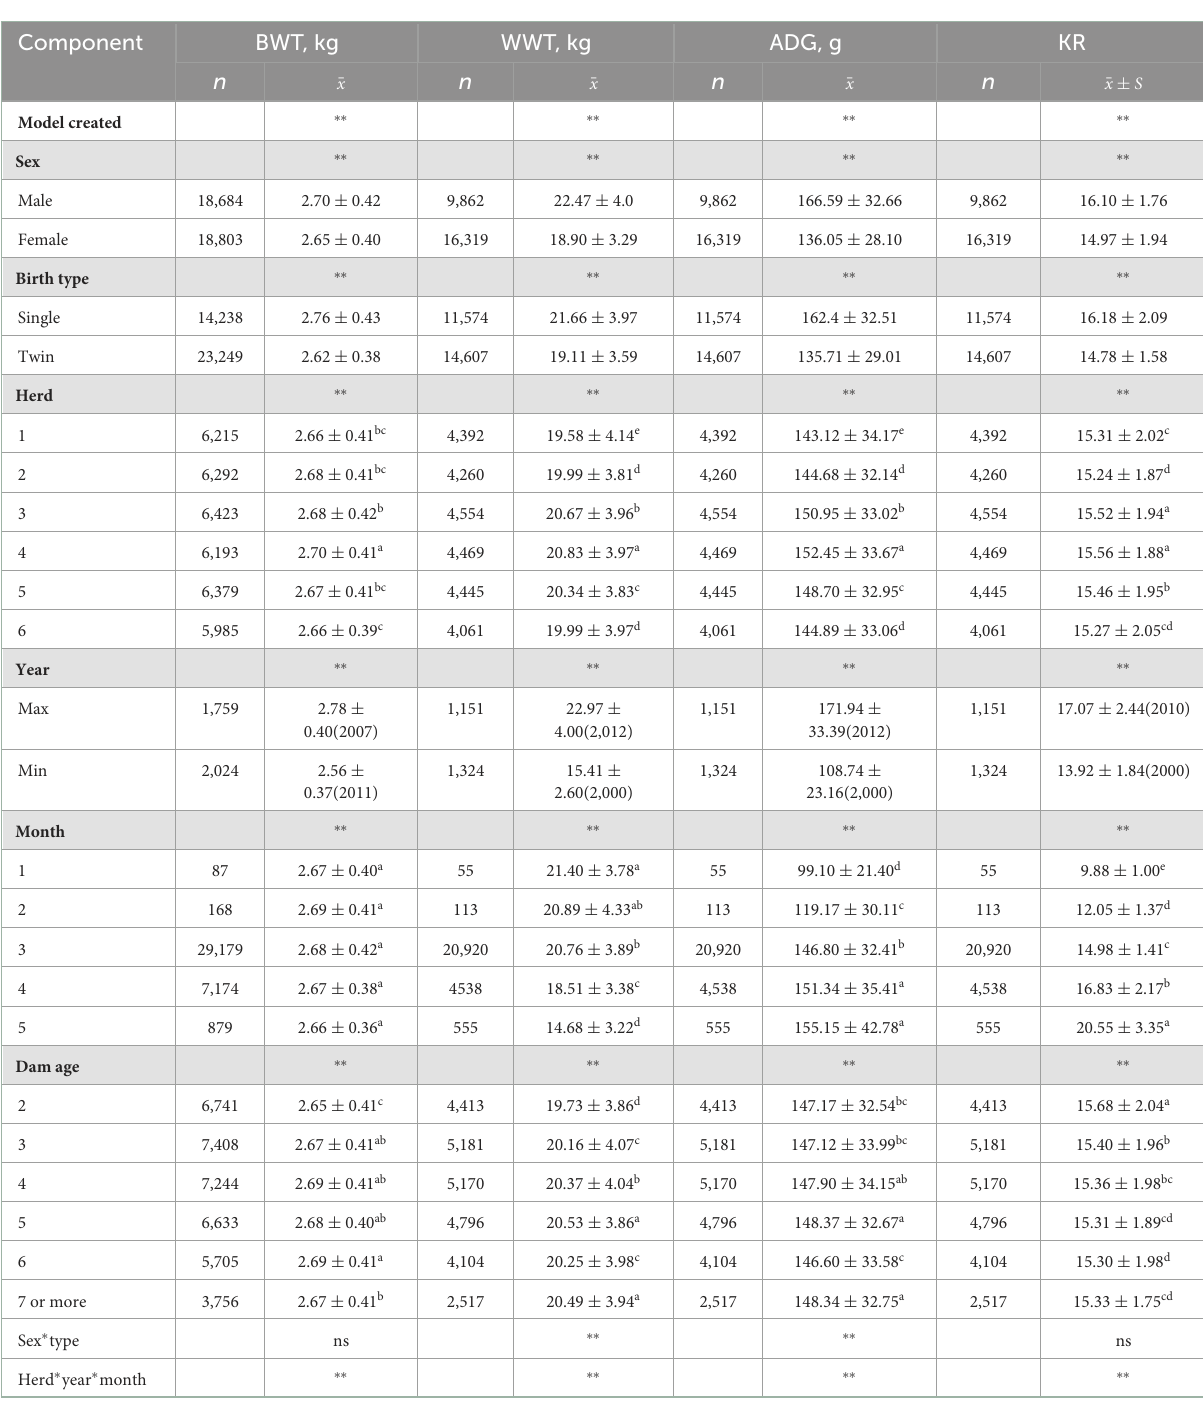
TABLE 2 Least-squares means ± S.D. for the studied traits. Component